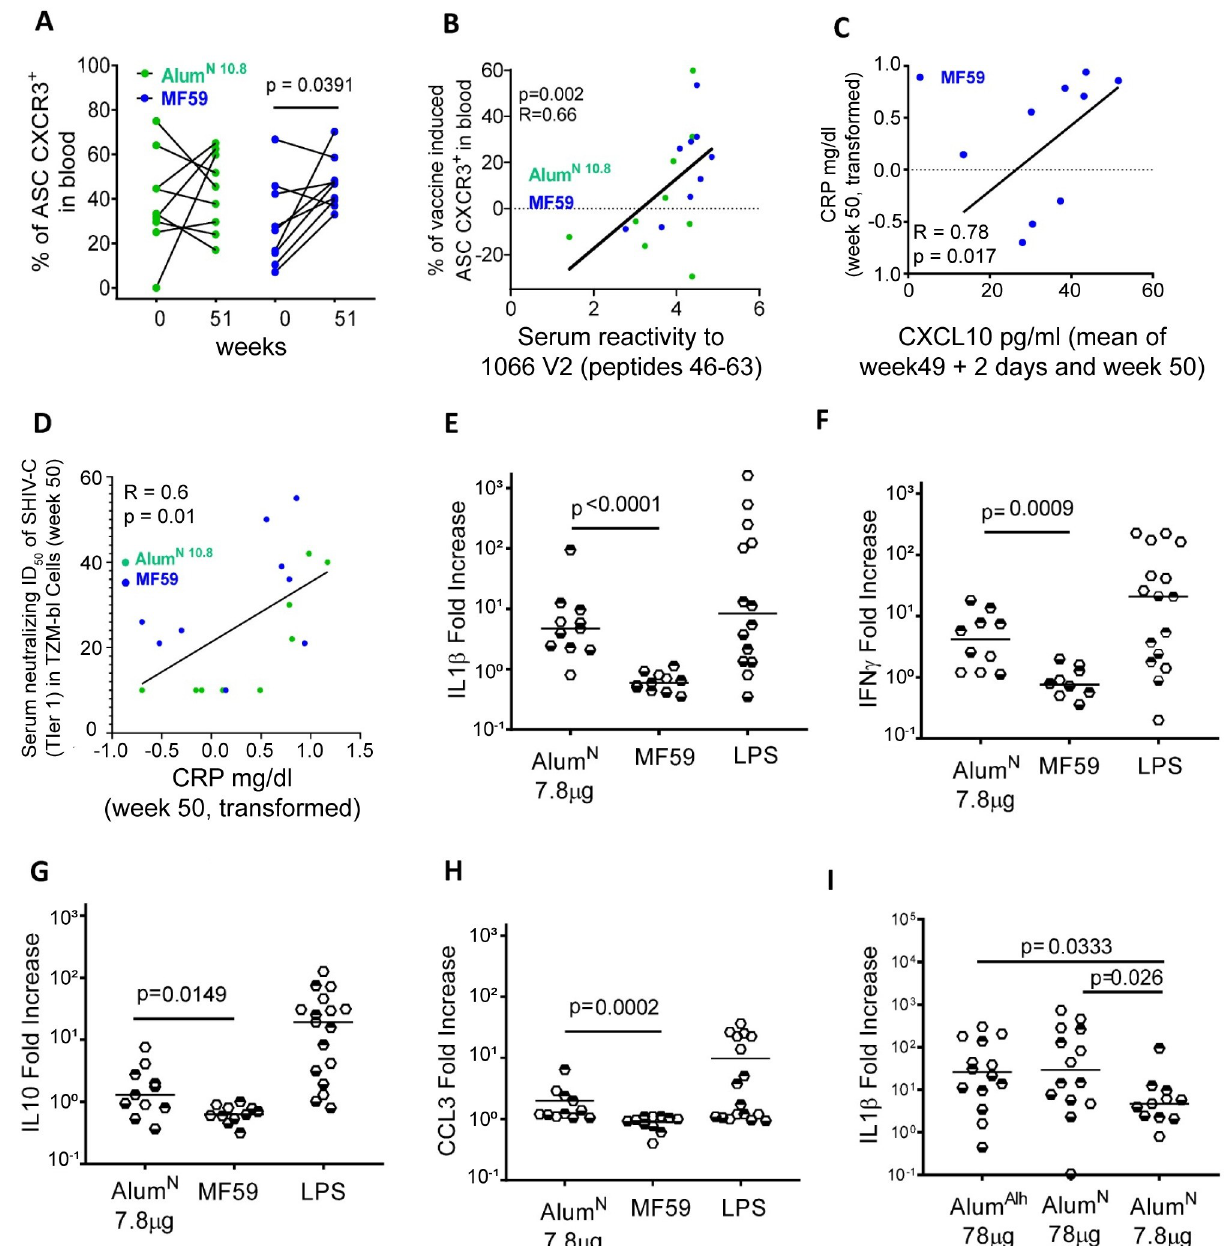
Fig 4. Inflammation parameters in immunized macaques. The vaccine-induced cells were calculated as the delta of weeks 51 and week 0. ASCs were defined as live cells, lineage- (CD3 - / CD14 - / CD16 - / CD56 + ) / (CD19 + / CD20 + / (CD21 - CD27 + ) / Ki67 +/++ / (CD38 +/++ / CD39 + ). (A) Frequency of blood circulating ASCs expressing CXCR3 on their membrane in Alum N10.8 (green filled circles) and MF59 (blue filled circles) before (week 0) and after immunization (week 51). (B) Spearman correlation between the sum of the serum reactivity to the 18 linear peptides encompassing the 1086 V2 (peptides 43–63) and frequency of vaccine-induced, blood-circulating CXCR3 + ASCs in Alum N10.8 and MF59 at week 51. The linear regression and P and R values were obtained using all 9 animals of the Alum N10.8 and MF59 groups. (C) Correlation between the levels of CRP (log transformed values) measured at week 50 and the mean of CXCL10 levels in serum measured in duplicate experiments (5 days apart: week 49 + 2 days, and week 50) in the MF59 group. (D) Correlation between serum neutralizing antibodies to SHIV Tier 1 CS in TZM-bl cells and C-Reactive Protein (log transformed- values) levels in all animals (9 animal each) of both Alum N10.8 and MF59. The linear regression and P and R values are derived from all 18 animals. (E) IL-1 β , (F) IFN- γ , (G) IL-10, and (H) CCL3 levels measured in human (empty hexagons), Indian rhesus macaque (dark-top hexagons), and Chinese rhesus macaque (dark-bottom hexagons) PBMCs after stimulation with Alum N , MF59, and LPS as positive control in all panels. (I) IL-1 β levels measured in human (empty circles), Indian rhesus macaque (dark-top hexagons), and Chinese rhesus macaque (dark-bottom hexagons) PBMCs after stimulation with Alum Alh (78 μ g) and Alum N at the same concentration (78 μ g) or in the same proportion (7.8 μ g) as used in vivo . Horizontal lines represent the median values in all panels.